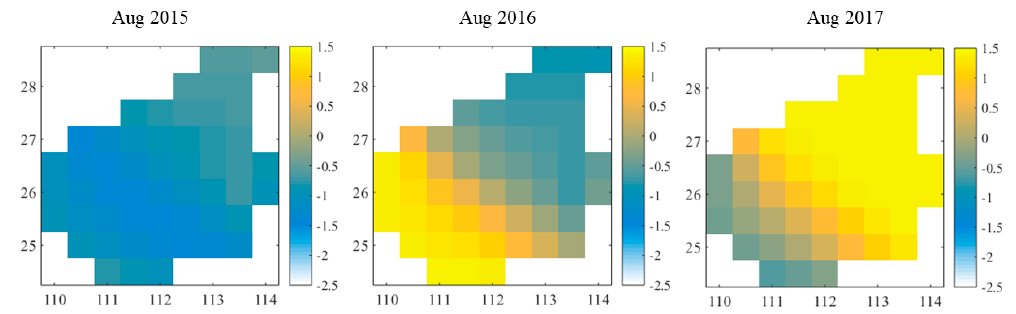
Figure 12. The distributions of IMERG V05 SPI-1 in August from 2015 to 2017.